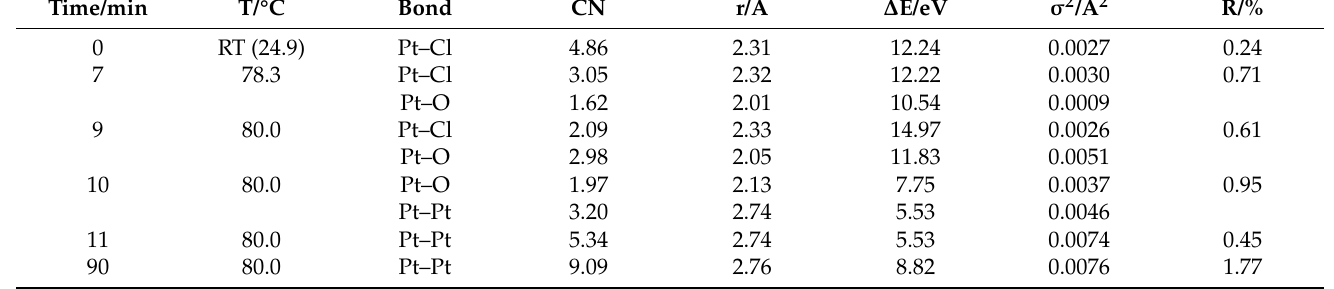
Figure 5. Fourier transforms of k 3 ‐ weighted Pt L 3 ‐ edge EXAFS spectra (radial distribution function). ( a ) The reference of Pt foil, glycol solution of H 2 PtCl 6 and PtO 2 ; ( b ) the reaction mixture for preparing unprotected Pt nanoclusters under different conditions. Reproduced with permission, Copyright